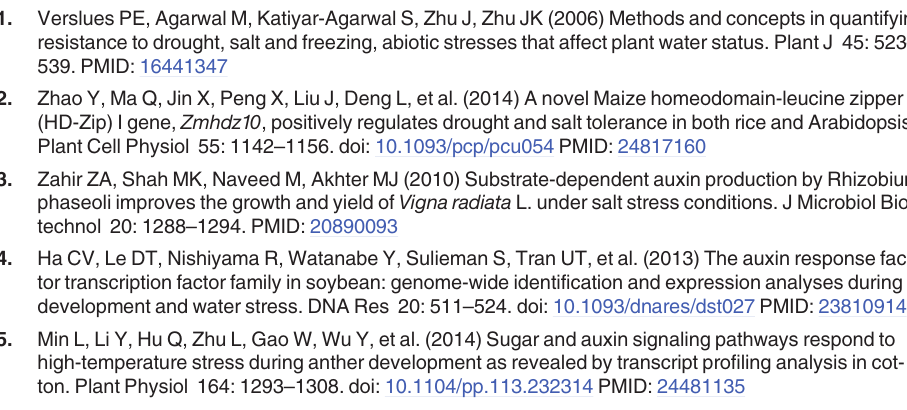
S1 Table. PIN , PILS , LAX and ABCB family genes in Arabidopsis and rice. a Locus ID of gene in TAIR database (http://www.arabidopsis.org/). b Accession number of corresponding protein existed in UniProt database (http://www.uniprot.org/). c The locus ID of genes in TIGR